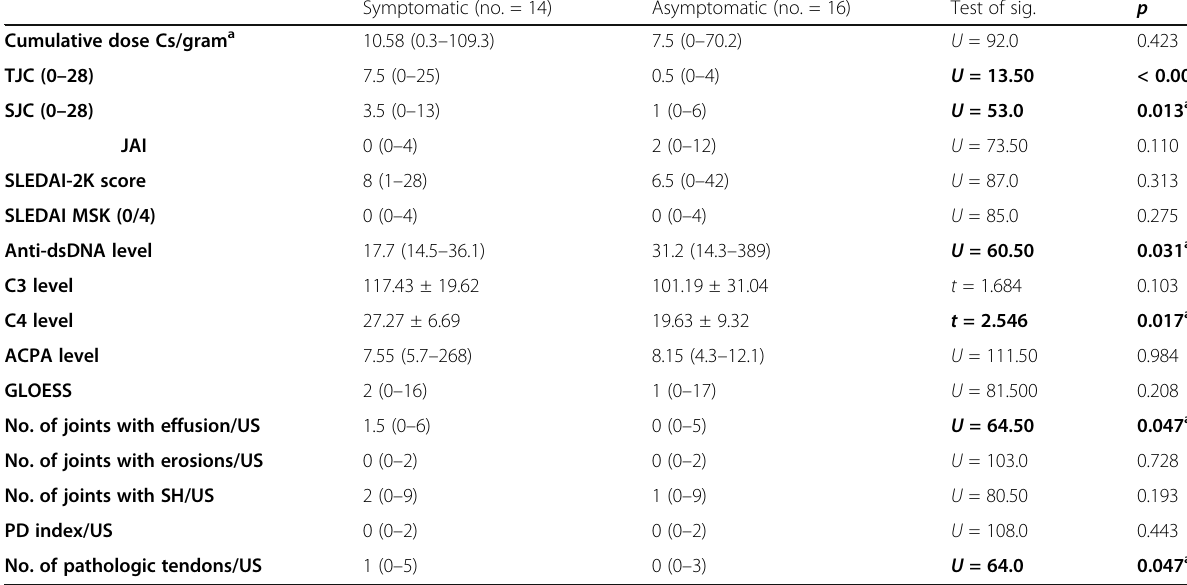
Table 2 Comparison between the symptomatic and asymptomatic patients regarding the different parameters Symptomatic (no. = 14) Asymptomatic (no. = 16) Test of sig.